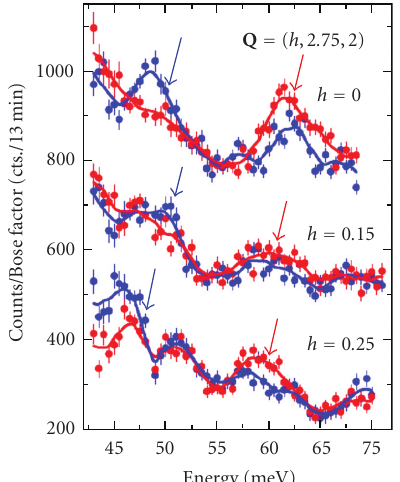
Figure 25: Energy scans taken at 200 K (red) and 10 K (blue). Data were taken with the final energy E f = 13.4 meV for E > 46meV and with E f = 12.5meV for 43 < E < 48meV. The 12.5-meV data were corrected for the di ff erent resolution volume by multiplying by (13.4/12.5) 2 . The resulting intensities were averaged in the overlapping energy range (46.5–48 meV). The 200K data were divided by the Bose factor and 23 counts were subtracted to correct for the temperature dependence of the background. Blue/red arrows indicate intensity gain/loss (from [74]).